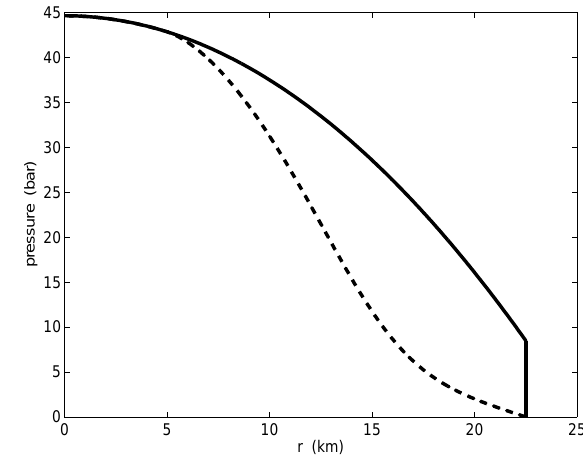
Figure 2. A nearly exact radial, steady solution for water thick- ness W(r) (dashed). In r -vs.- W space the overpressure ( O ), normal pressure ( N ), and under-pressure ( U ) regions (solid curves) are de- termined by ice geometry and sliding velocity, because this is steady state.